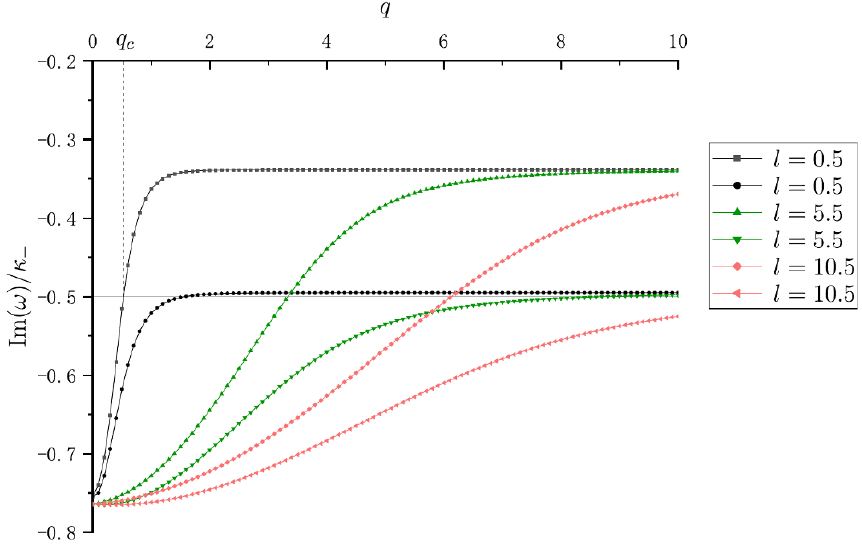
Figure 2 . The low-lying QNMs for (cid:3) = 0 : 06 and Q=Q max = 0 : 996.